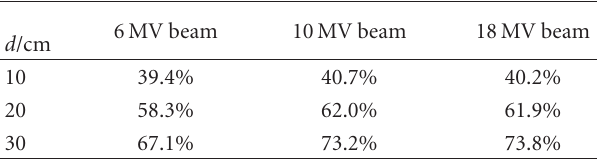
Table 2: Detection e ffi ciencies of CPID for three clinical beams. Statistical uncertainty for each value is ∼